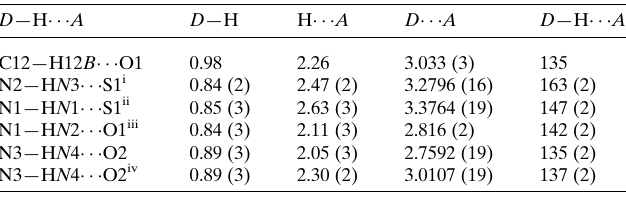
Table 1 Hydrogen-bond geometry (A˚ , (cid:2)